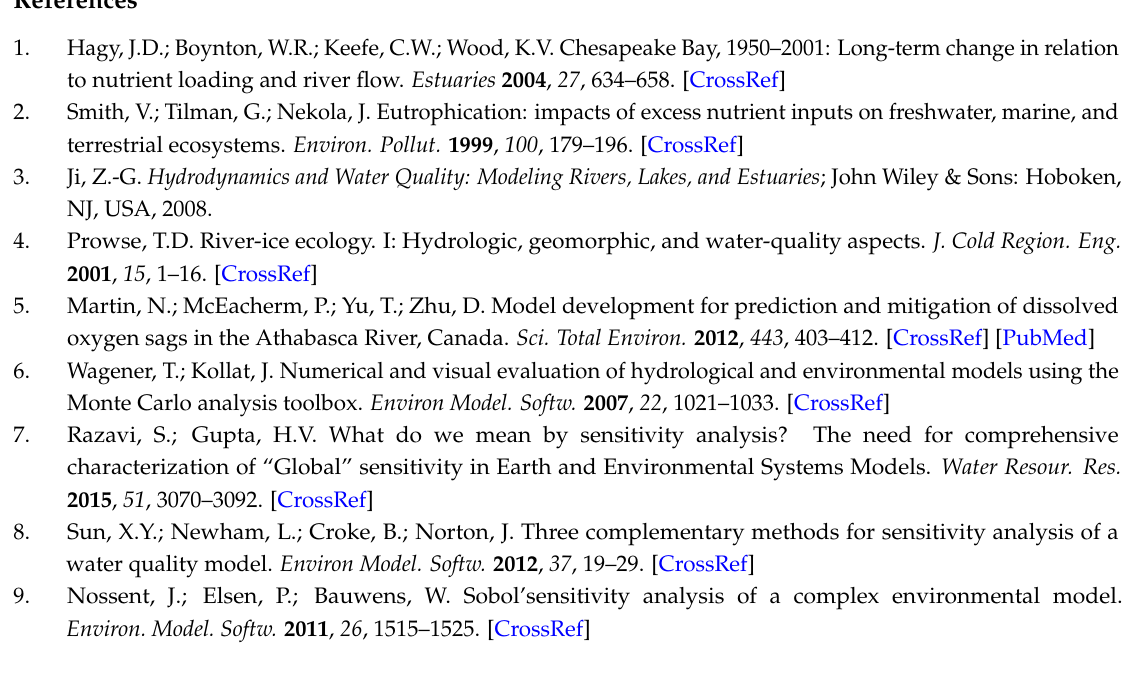
Figure S1: (a) daily measured flow at the Medicine Hat gauging station in uSSR the Saskatoon gauging station in lSSR; (b) measured water temperature, and (c) daily measured solar radiation., Table S1: Upstream boundary conditions of lSSR, Table S2: title Upstream boundary conditions at upstream (confluence of Bow and Old Rivers) of uSSR, Table S3: Boundary conditions at confluence Red Deer River at